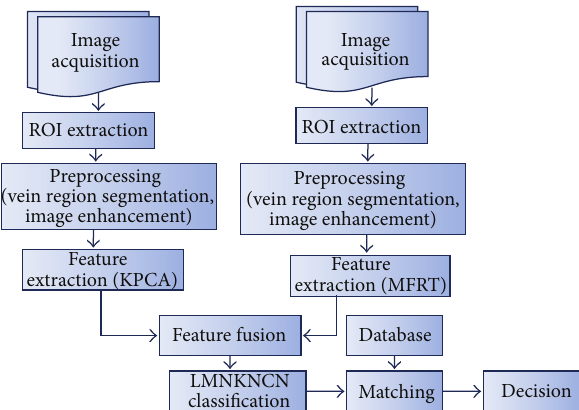
Figure 2: Block diagram for personal identification using multi- spectral palm print biometric